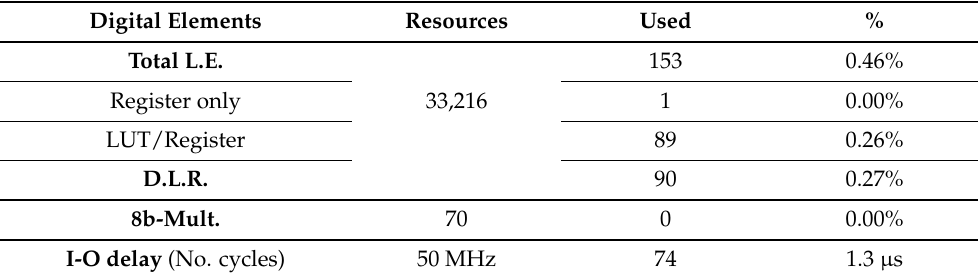
Table 10. Hardware resources used by